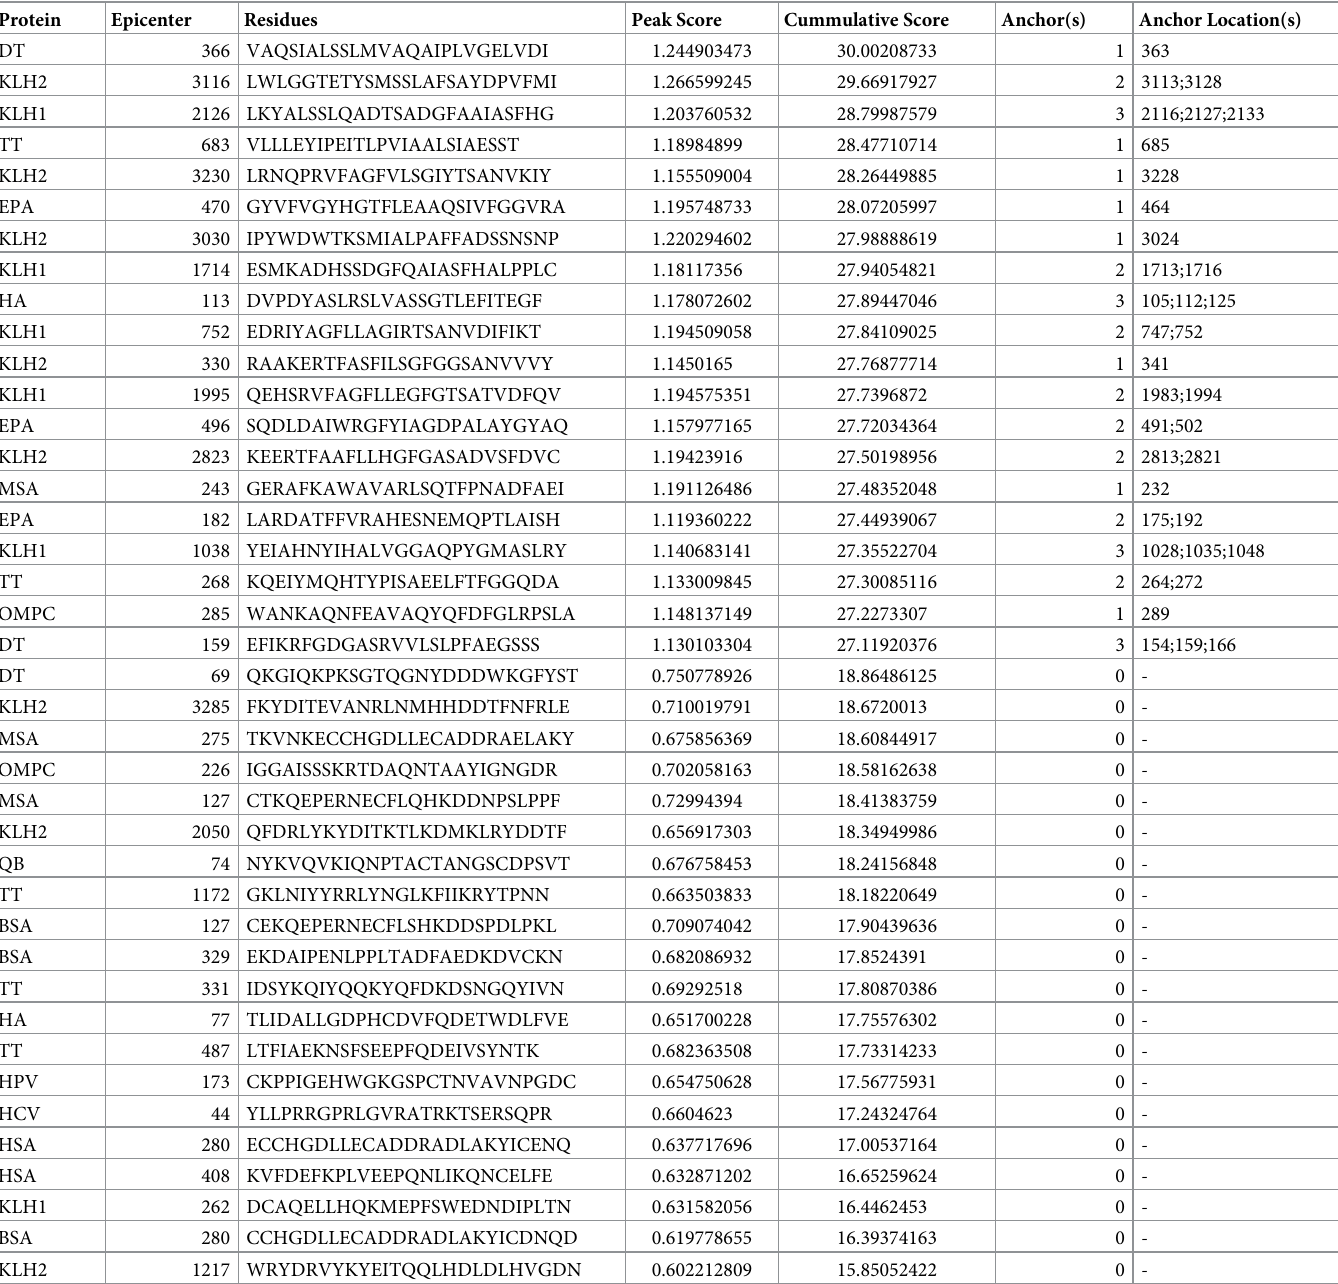
Table 3. HLA-DQ epitope ranking and excision results.